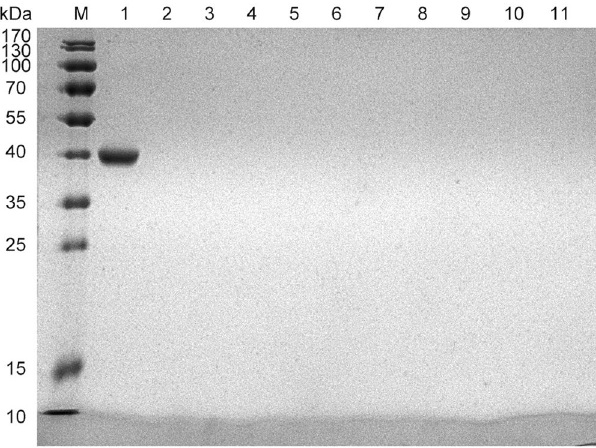
Figure 4. Affinity chromatography. “M” indicates a protein molecular weight marker. Lane 1 shows that lactose-modified Sepharose 6b could recover GST-Gal3_111-250 (41.5 kDa) 34 . Lane 2 shows that Sepharose 6b without modification could not recover Gal-13. Lane 3–6 indicates that lactose-, arabinose-, maltose-, and sucrose-modified Sepharose 6b also could not recover Gal-13. Lane 7 shows that Sepharose 6b without any modification could not recover R53H. Lane 8–11 indicates that lactose-, arabinose-, maltose-, and sucrose- modified Sepharose 6b also could not recover R53H.